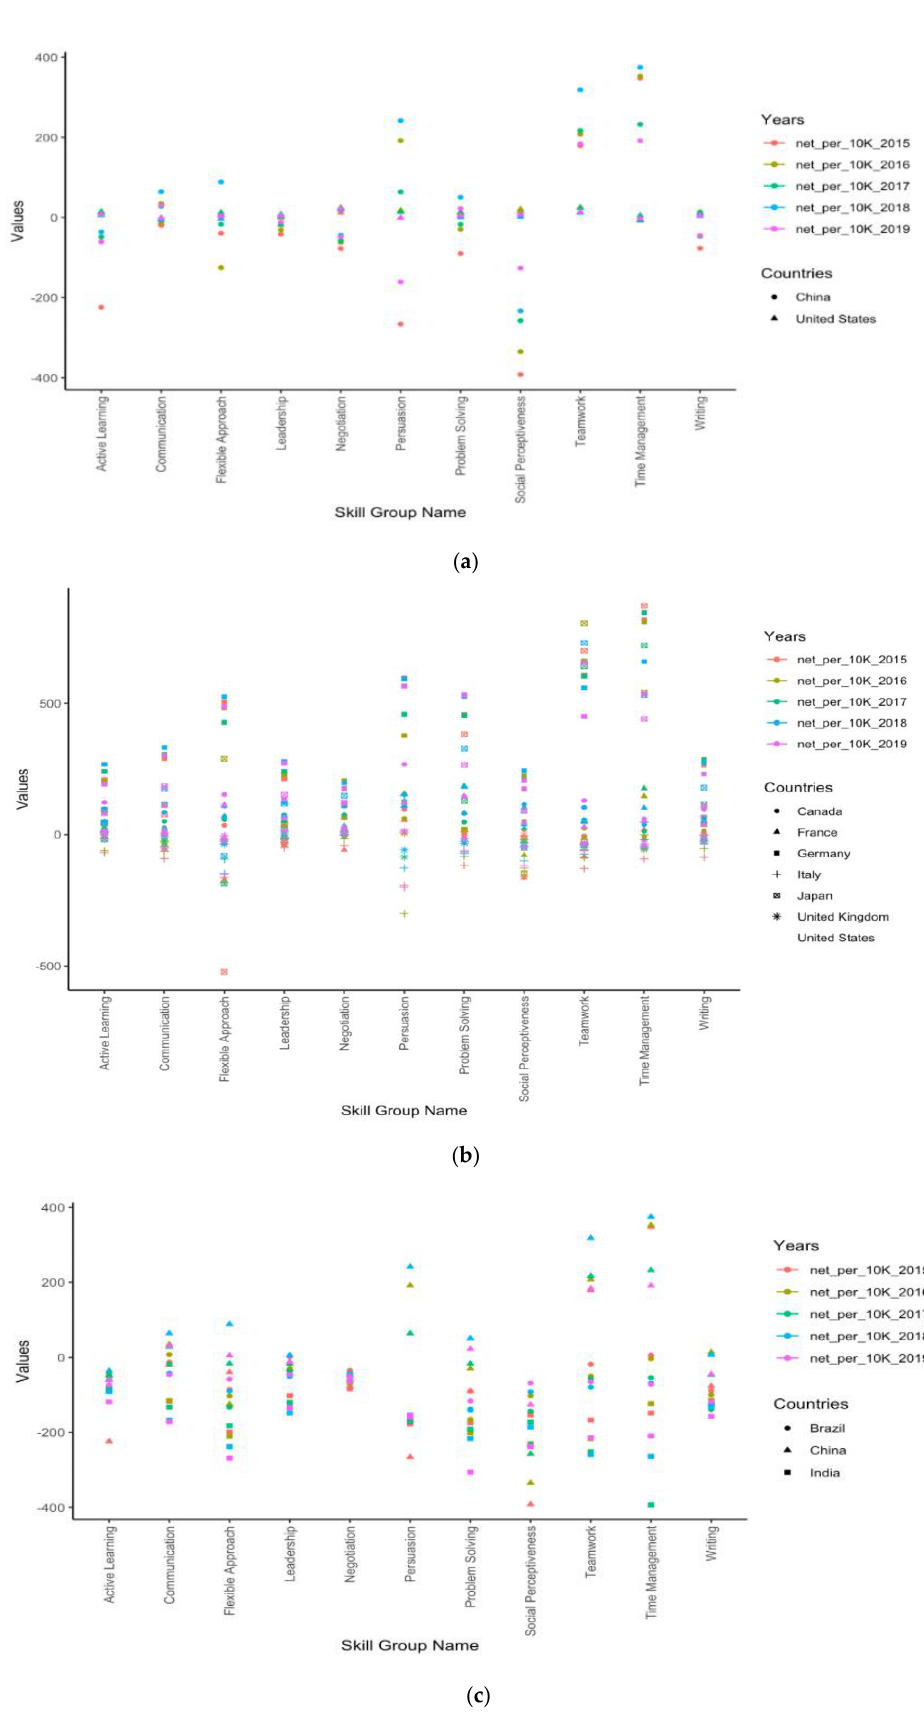
Figure 4. Soft skills migration in ( a ) China and the US, ( b ) G7 countries, and ( c ) BIC countries.